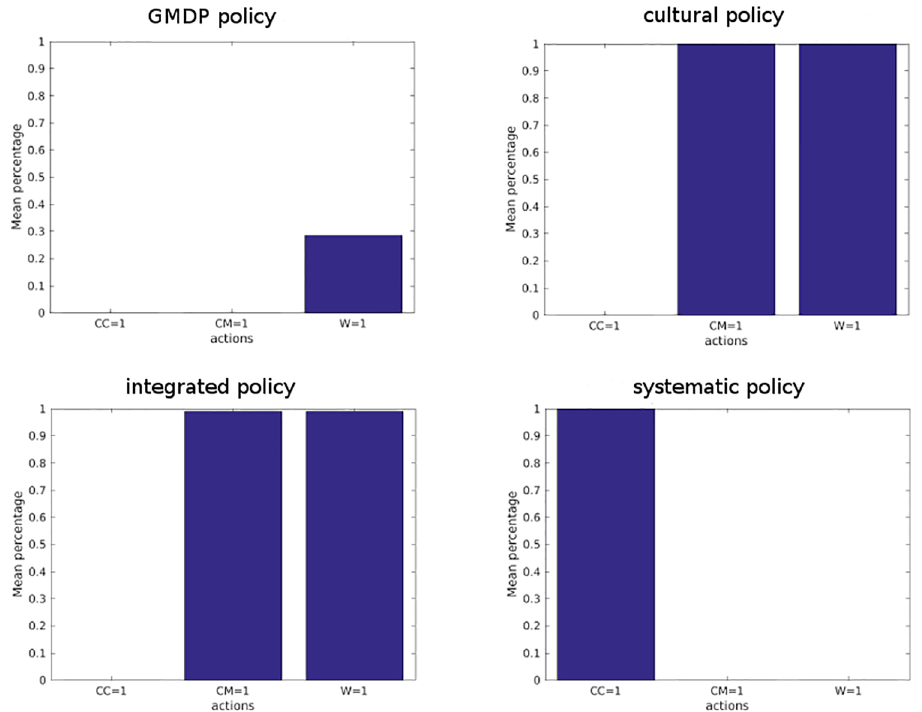
Fig 5. Proportion of use of each action modality, in averageover 100 simulations of 100 yearsof blackleg dynamics. A bar indicatesthe proportionof times modality 1 of a given action is applied in a canola field. Modality 1 for actions CC, CM and W corresponds respectivelyto the choice of the resistant cultivar, the application of a canola management plan unfavorableto blackleg,and plowing.